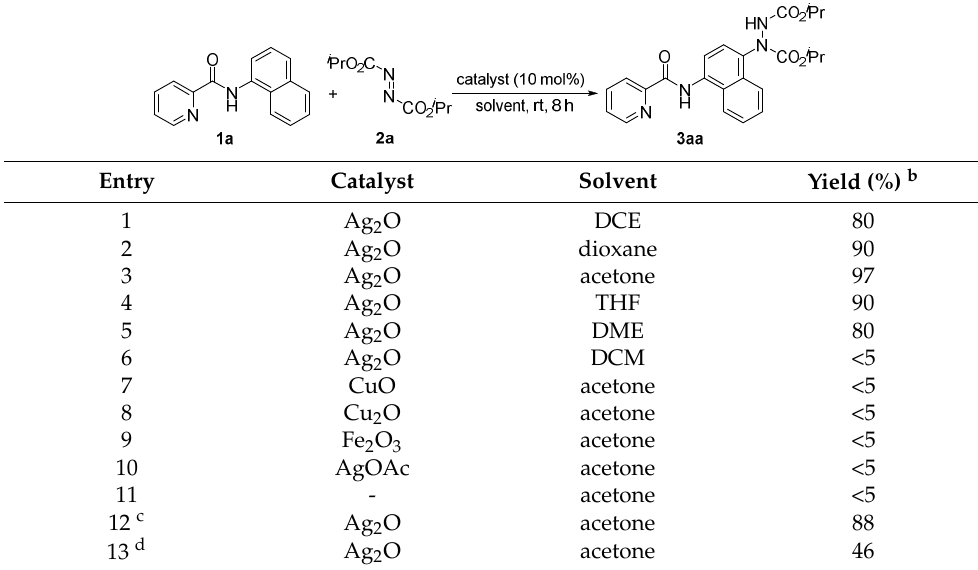
Table 1. Optimization of the reaction conditions a .